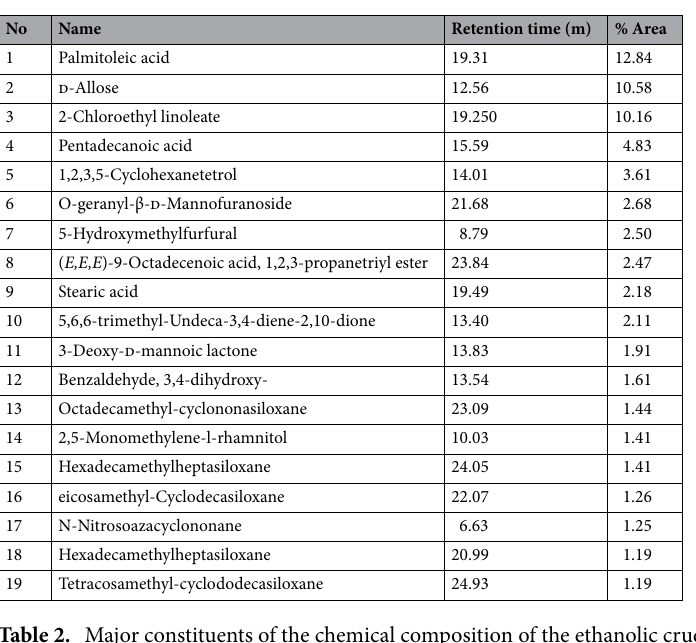
Table 2. Major constituents of the chemical composition of the ethanolic crude extract of HH corms using GC–MS. Other trace components < 1.00%.